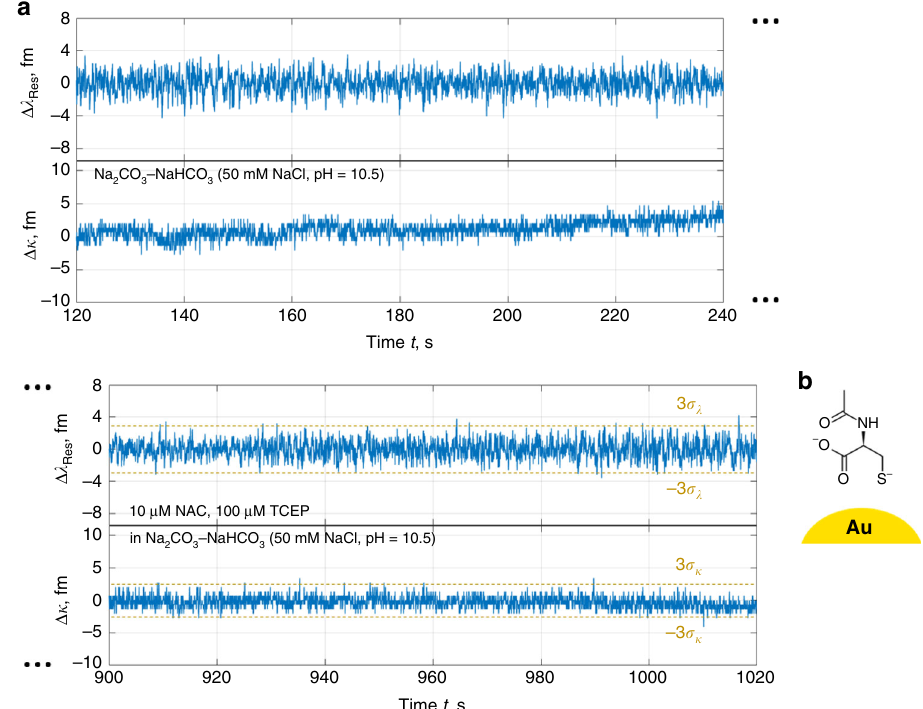
Fig. 3 Background and negative control measurement with NAC at micromolar concentration. a Resonance and linewidth shift traces exhibiting transient signal above 3 σ with rates on the order of 0.1 s − 1 over several minutes; however, these persist in the presence and absence of NAC and TCEP in solution. No permanent binding patterns were found during peak tracking. b NAC molecule, with carboxyl, thiol, and (amine-attached) acetyl groups, near a detection